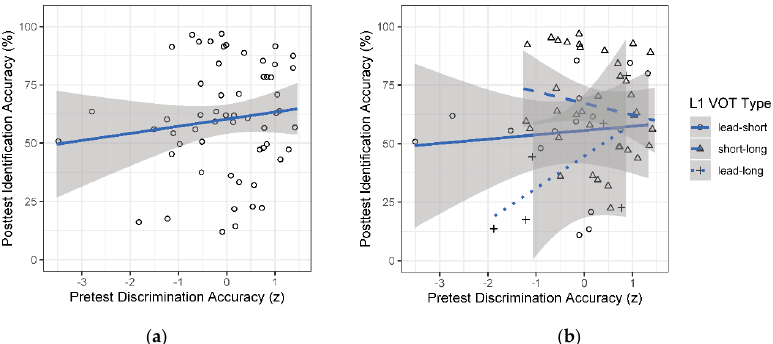
Figure 6. Individual posttest accuracy in the stop study by pretest performance, with regression lines ( a ) over all L1 groups together, and ( b ) over each L1 group separately. Points are jittered; the shaded areas indicate the 95% confidence interval around the regression line.